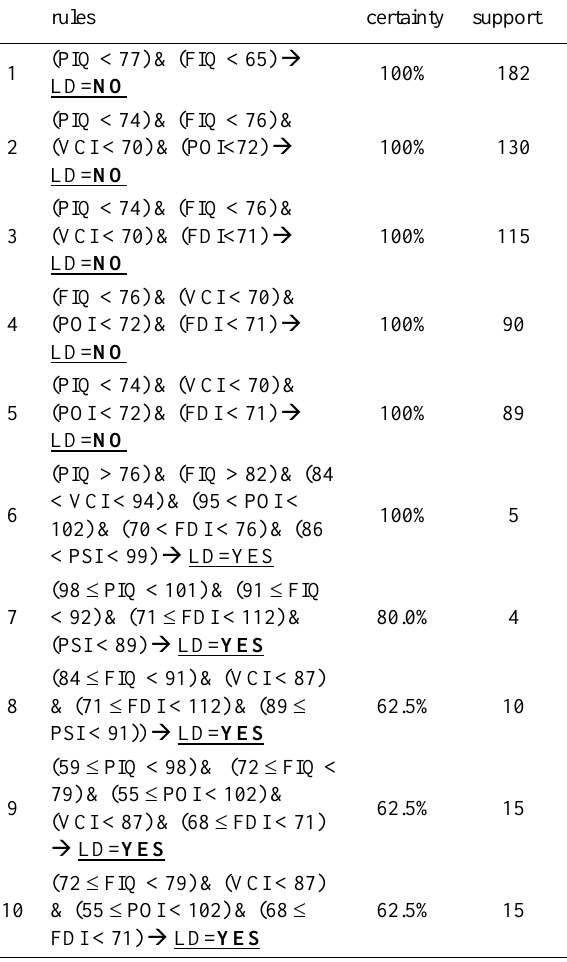
Table 11. Rules generated from data set A ∪ B without clustering prior to rules